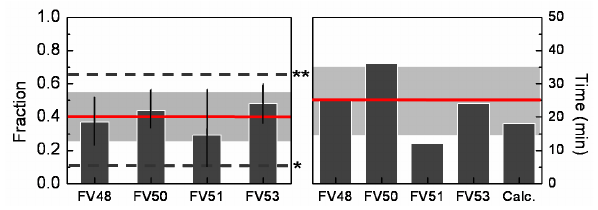
Fig. 11. Deep convection characteristics in West Africa. Left plot: Fig. 11: Deep convection characteristics in West Africa fraction of low tropospheric air in fresh convective outflow for each Left plot: Fraction of low tropospheric air in fresh convective outflow for each MCS. Vertical MCS. Vertical bar is the standard deviation of the average of all bar is the standard deviation of the average of all calculated fractions with the different calculated fractions with the different NMHC, the red line is the NMHC, the red line is the global mean fraction, the grey area is the standard deviation of the global mean fraction, the grey area is the standard deviation of the global mean fraction, the dashed lines are the minimum and maximum fraction value reported global mean fraction, the dashed lines are the minimum and max- in the literature. .: Ray et al., 2004 in mid-latitude convection, ** : Cohan et al., 1999 in imum fraction value reported in the literature. ∗ Ray et al., 2004 marine tropical convection. in mid-latitude convection, ∗∗ Cohan et al., 1999 in marine tropical convection. Right plot: vertical transport timescale for each MCS Right plot: Vertical transport timescale for each MCS compared to theoretical time (Calc.) compared to theoretical time (Calc.) calculated (vertical wind speed calculated (vertical wind speed of 15m.s -1 , 12 km-altitude). The red line indicates mean of 15ms − 1 , 12km-altitude). The red line indicates mean transport transport time, the grey area is the standard deviation of the mean transport time. time, the grey area is the standard deviation of the mean transport